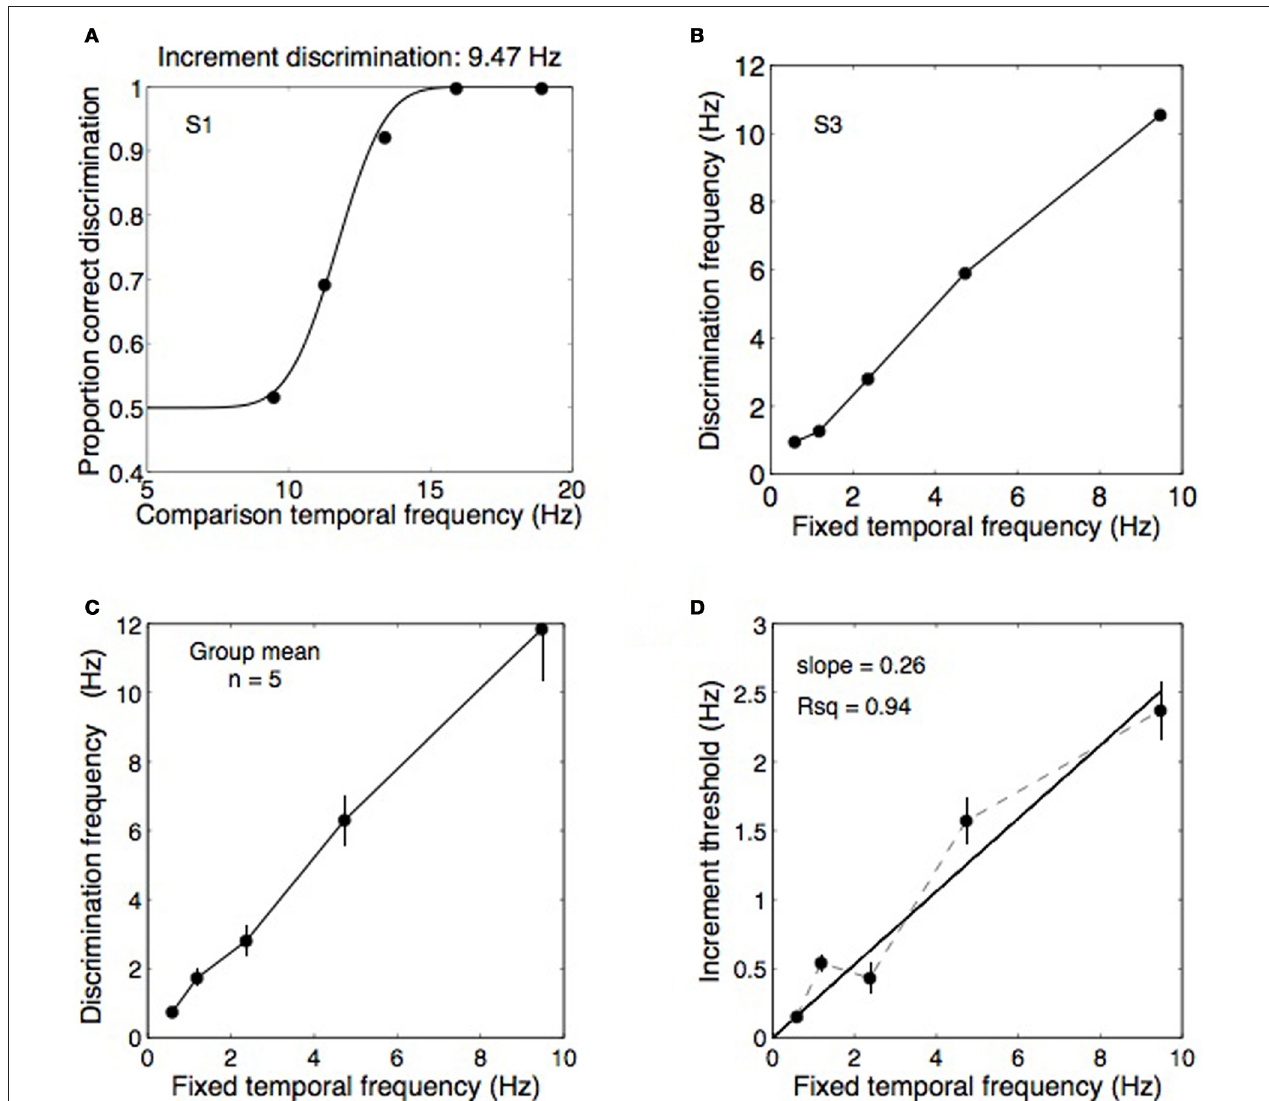
FIGURE 4 | Data from Experiment 2A showing temporal frequency discrimination performance for a range of base frequencies. (A) An example psychometric function from one observer discriminating temporal frequency increments on a 9.47Hz standard. In this example, threshold performance was obtained at a frequency of 11.7Hz. (B,C) Thresholds obtained as in panel (A) were measured for five standard frequencies: 0.59, 1.18, 2.37, 4.73, and 9.47Hz and the data from five observers was pooled into